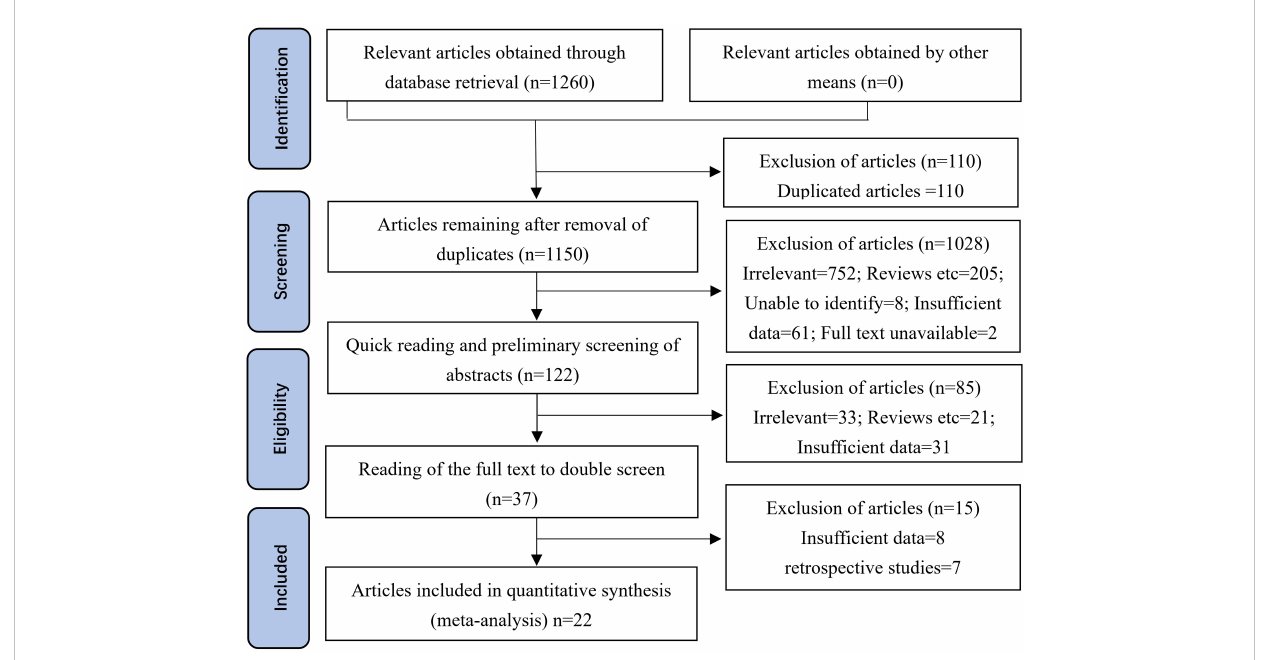
FIGURE 1 Methodological PRISMA (Preferred Reporting Items for Systematic Reviews and Meta-Analyses) fl owchart for the selection of the studies included in this meta-analysis. A total of 306 studies were obtained from PubMed, 107 from Embase, 77 from the Cochrane Library, 100 from the Web of Science, 13 from ClinicalTrials.gov, 657 from Research Square, and 0 from OpenGrey or other sources of gray